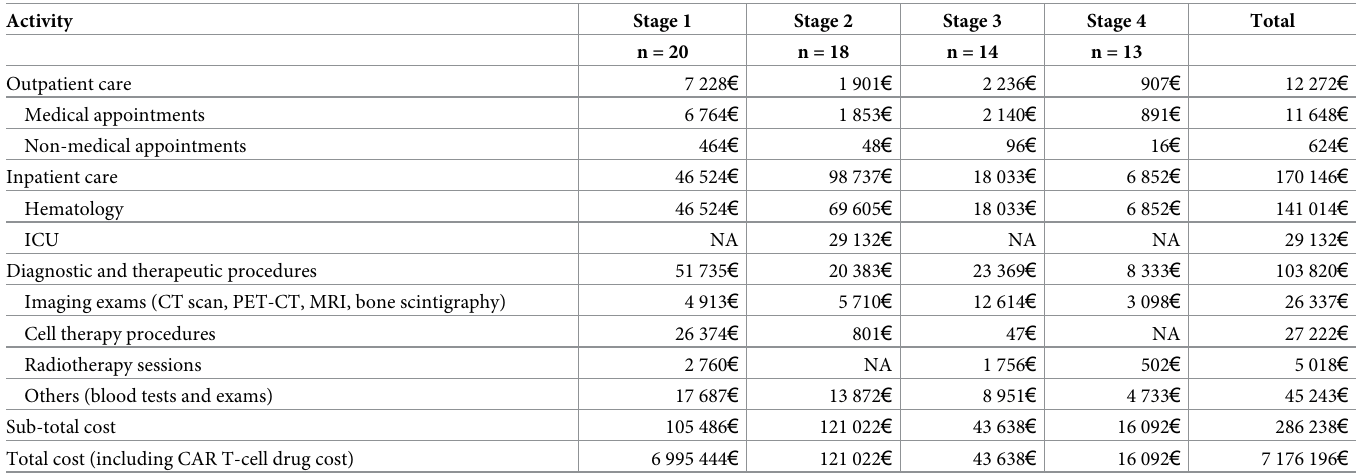
Table 5. Costing by